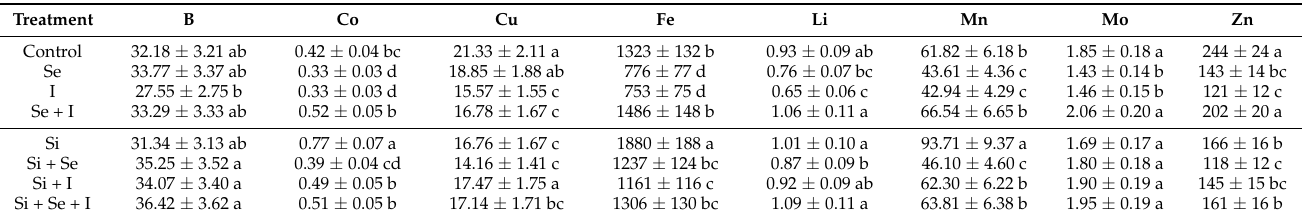
Table 6. Levels of micro-element accumulation in chervil shoots under single and joint application of Se, I and Si.